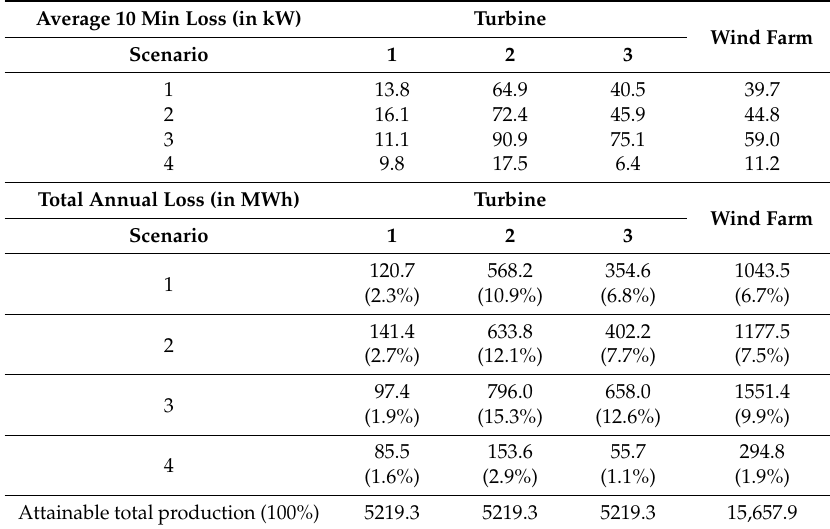
Table 6. Estimated losses for hypothetical wind farms in different